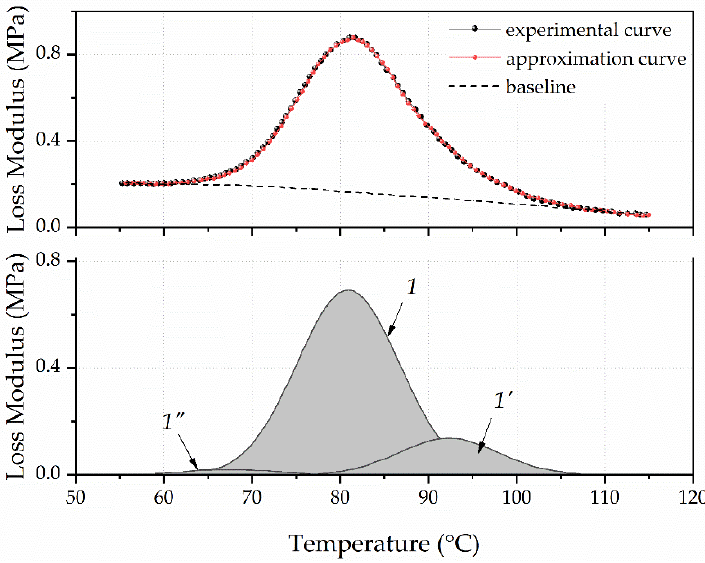
Figure 4. Approximation of the experimental peak of the unfilled polyurethane’s mechanical loss modulus.